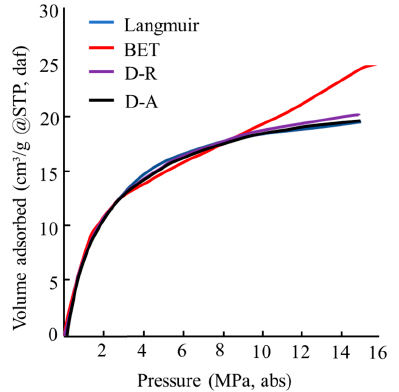
Figure 5. Adsorption isotherm curves based on the Langmuir, BET, D-R and D-A methods. Adapted from [110].